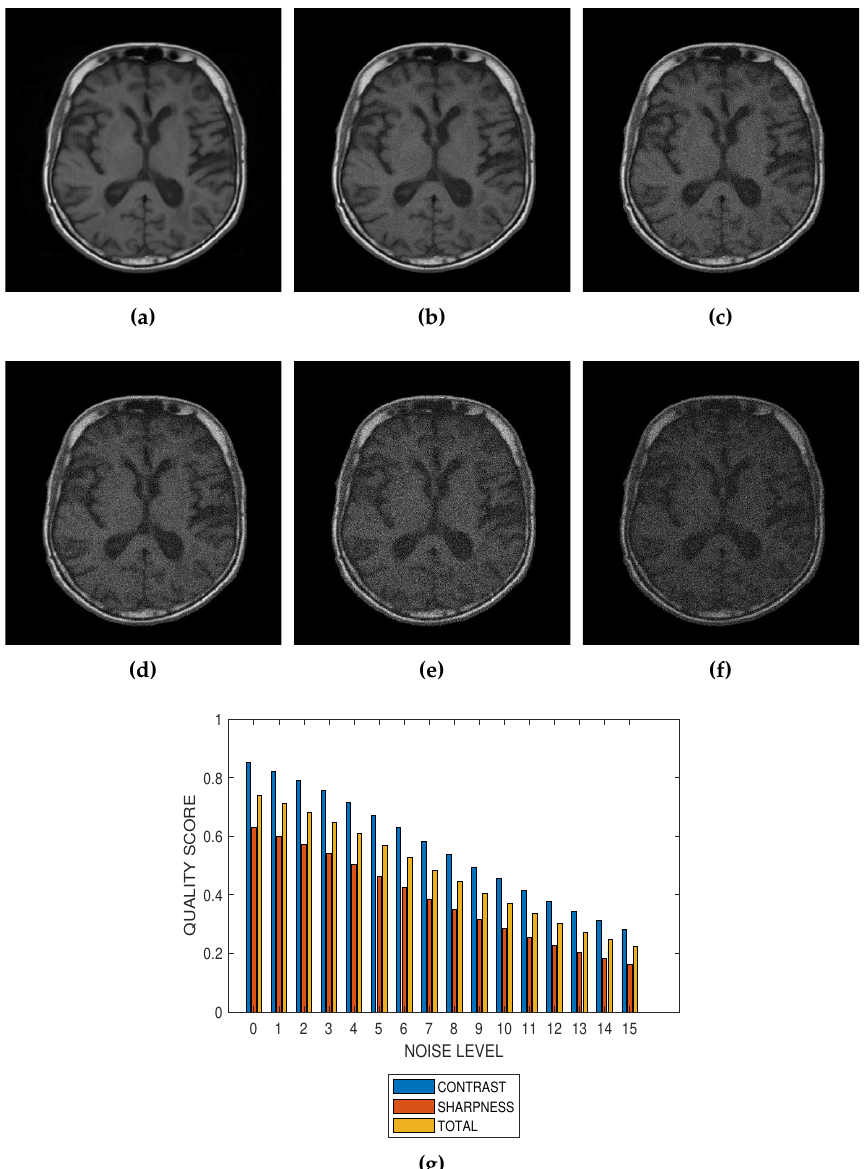
Figure 5. ( a ) A conventional T1 weighted MRI slice from BrainCare Oy., and its degraded versions at Rician noise levels ( b ) 3 percent, ( c ) 6 percent, ( d ) 9 percent, ( e ) 12 percent and ( f ) 15 percent. ( g ) Variation of contrast, sharpness and total quality scores for Rician noise levels that vary from 0 percent to 15